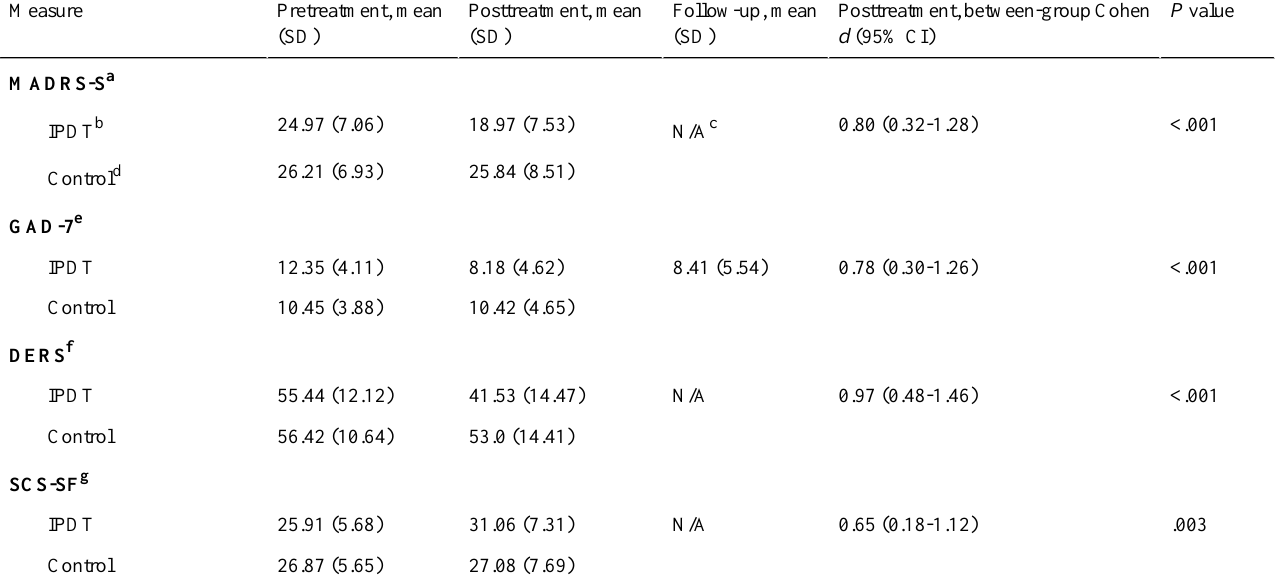
Table 3. Secondary outcome results.